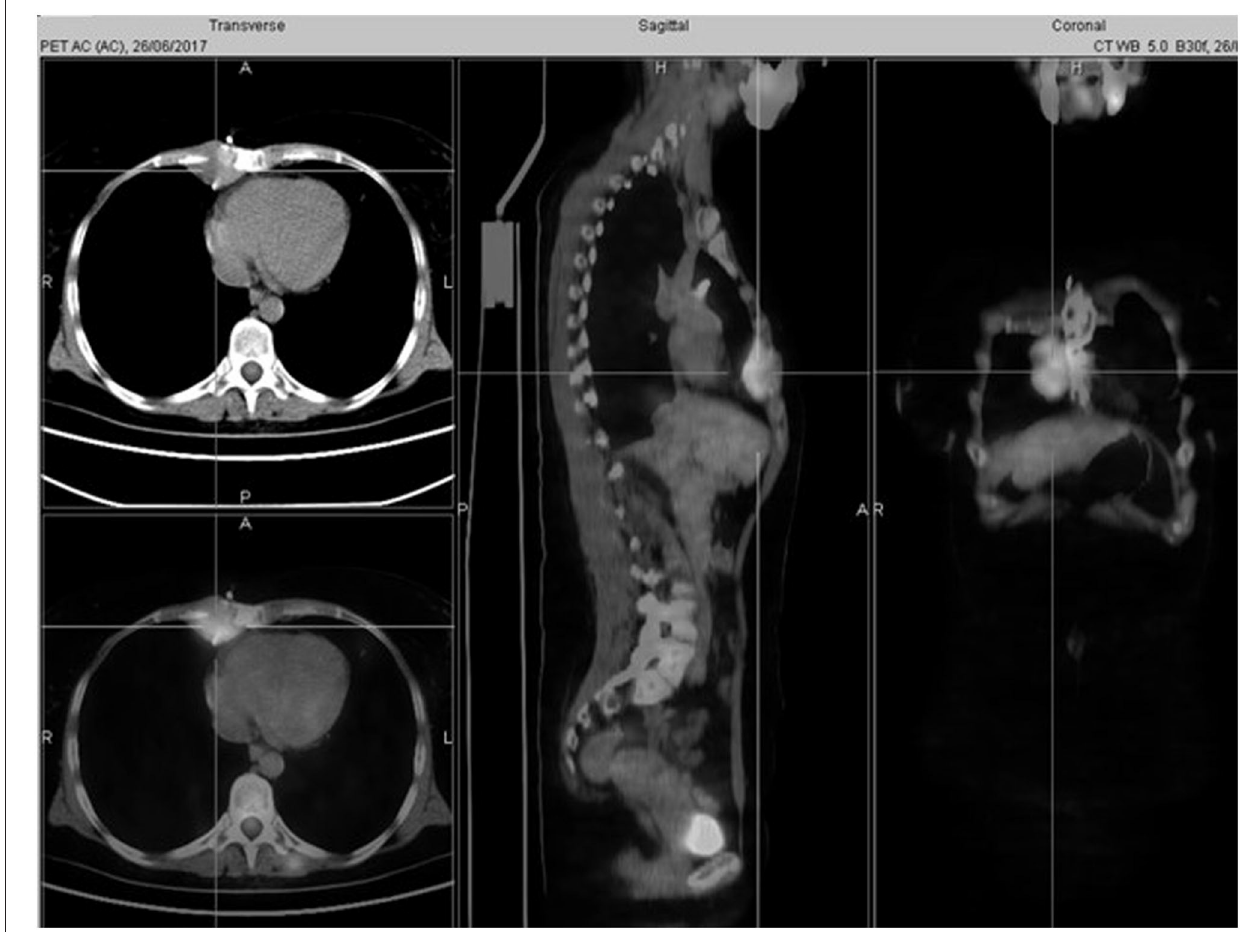
FIGURE 3 | Preoperative PET/CT displayed a right paramediastinal mass infiltrating the sternal